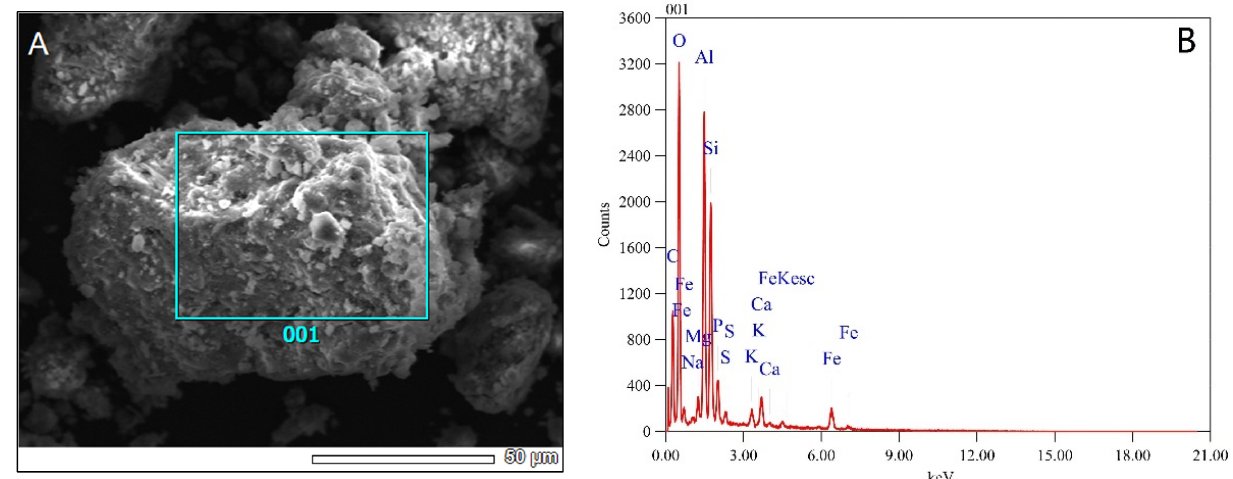
Figure 1. SEM image ( A ) and EDX elemental analysis ( B ) of as-prepared biochar. The surface and pore features of as-prepared magnetic biochar were detected by a nitrogen test. As depicted in Figure 2A, the isotherm curves are consistent with the IUPAC classification type IV curve and the H 3 -type hysteresis loop. The S BET was calculated as 93.41 m 2 /g, and the average pore size was 9.017 nm. The isotherm has no obvious inflection point in the low relative pressure region, indicating that the magnetic biochar has a low proportion of micropores. The lack of a saturated adsorption platform in the medium relative pressure area indicates that the biochar has irregular pores and